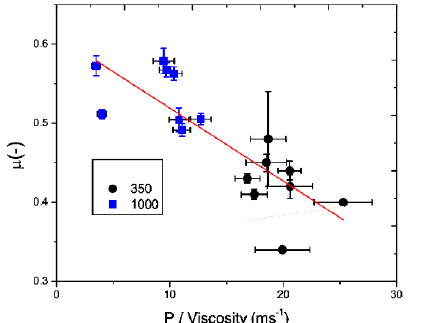
Fig. 5. Friction coefficient as a function of the penetration hardness which is normalized to viscosity. All were obtained as a function of the water volume fraction as given in Figure 4. For increasing hardness, a linear decrease of the friction coefficient is found; it becomes easier to slider over a hard and stiff glass beads- silicone oil mixture.